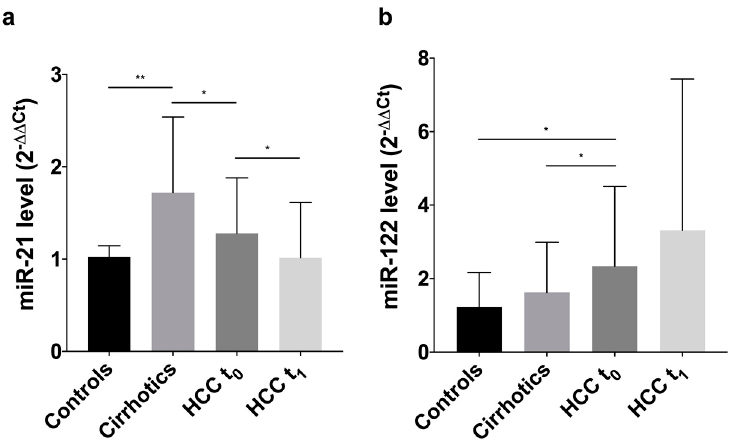
Figure 1. Histograms showing circulating levels of miR-21 and miR-122 in controls, cirrhotics, HCC patients at t 0 and t 1 (representing median with error bar showing the third quartile). ( a ) The median of miR-21 circulating levels is 1.03 fc [0.74–1.15] in controls, 1.72 fc [1.13–2.54] in cirrhotics, and 1.28 fc [0.78–1.88] in patients with HCC at t 0 . There is a significant difference in the circulating level between controls and cirrhotics ( p = 0.009) and between cirrhotics and HCC patients ( p = 0.047). In HCC, the miR-21 levels at t 0 are significantly higher than those measured at t 1 (1.02 fc [0.69–1.66]; p = 0.03); ( b ) the median of miR-122 circulating levels is 1.22 fc [0.39–2.17] in controls, 1.63 fc [0.51–2.99] in cirrhotics, and 2.34 fc [1.36–4.51] in HCC patients at t 0 . There is a statistically significant difference in the levels of the miRNA comparing HCC patients with controls ( p = 0.02) and cirrhotics ( p = 0.04). In HCC patients, no significant differences are present in t 0 and t 1 levels of miR-122. * p < 0.05; ** p ≤